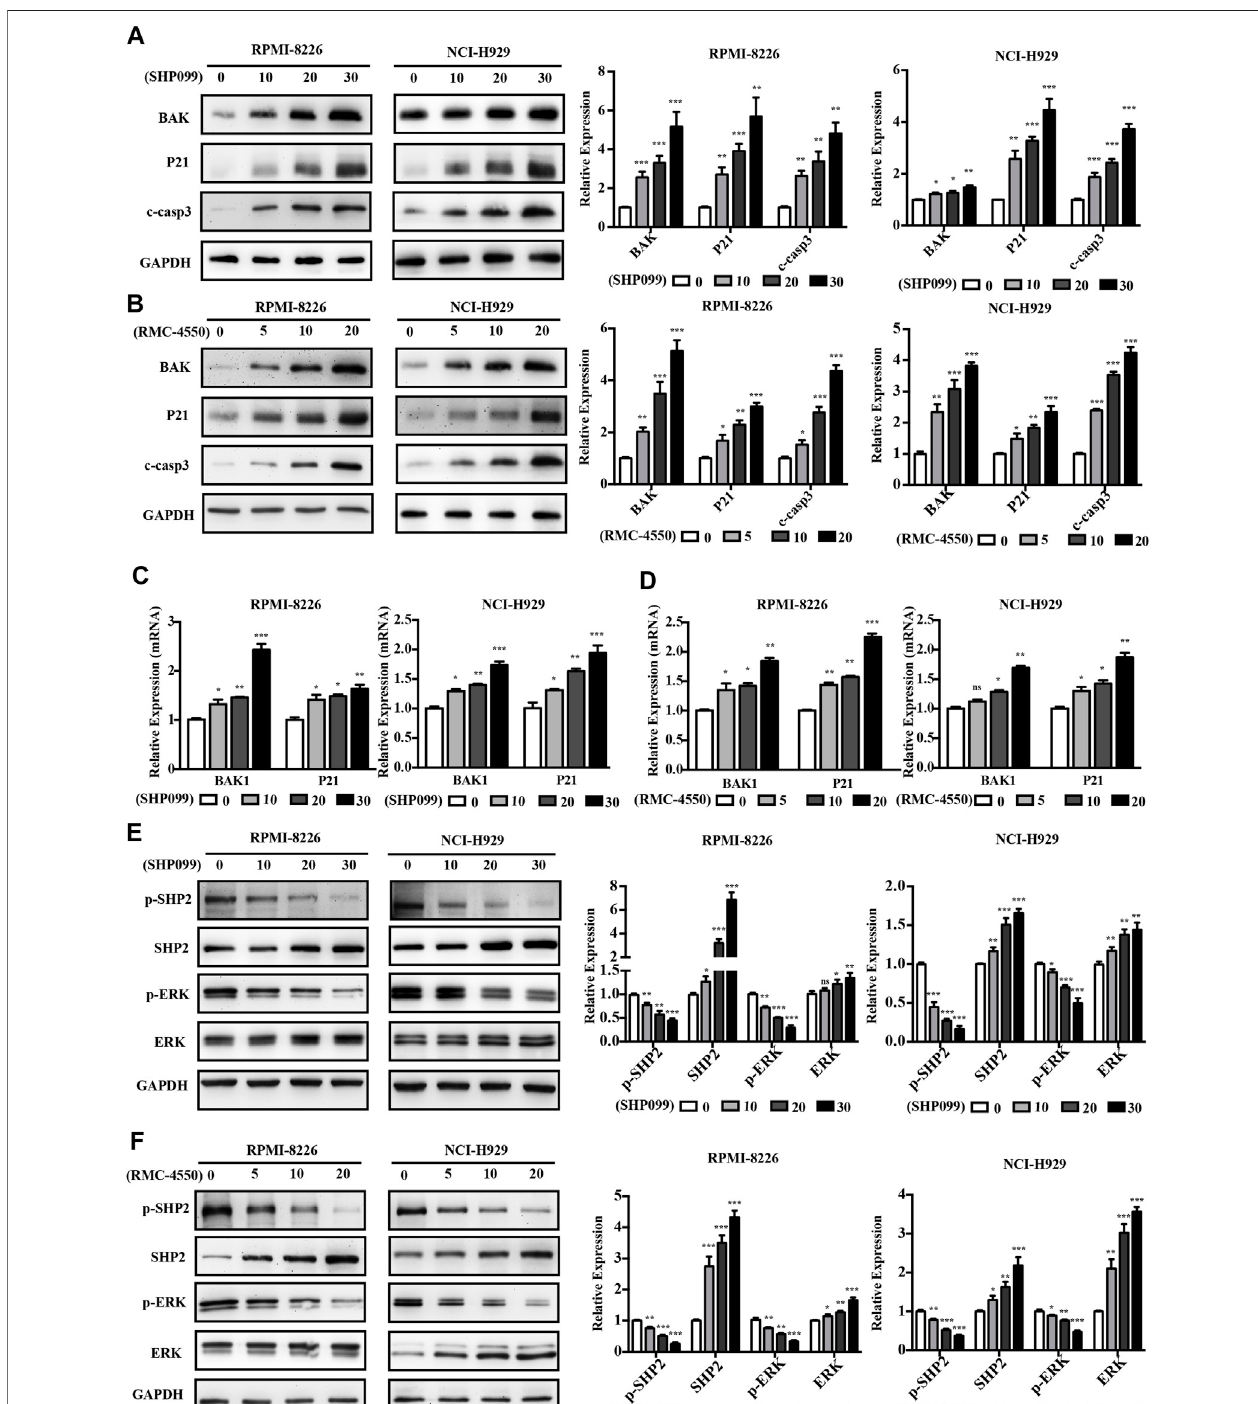
FIGURE 4 | SHP2 inhibitors induce the expression of apoptosis and cell cycle – related genes and impede the activation of the SHP2/ERK pathway in MM cells. (A,B) Western blotting analysis showed that treatment with SHP099 or RMC-4550for 48 h signi fi cantly enhanced cleaved caspase-3, BAK, and P21 expression in MM cells. (C,D) mRNA expressions of BAK and P21 were upregulated in RPMI-8226 and NCI-H929 cells after incubation with SHP099 or RMC-4550 for 48 h. (E,F) Expression levels of p-SHP2 and p-ERK were reduced in RPMI-8226 and NCI-H929 with SHP099 or RMC-4550. The proteins were detected using ImageJ software,andtheintensityratios ofimmunoblotswerecompared tothoseofthecontrolandwerequanti fi edafter normalizing withtherespectiveloadingcontrolsforthe housekeeping protein GAPDH. The data were obtained in at least three independent experiments and expressed as mean ± SD of three individual experiments. * p < 0.05, ** p < 0.01, and *** p < 0.001.